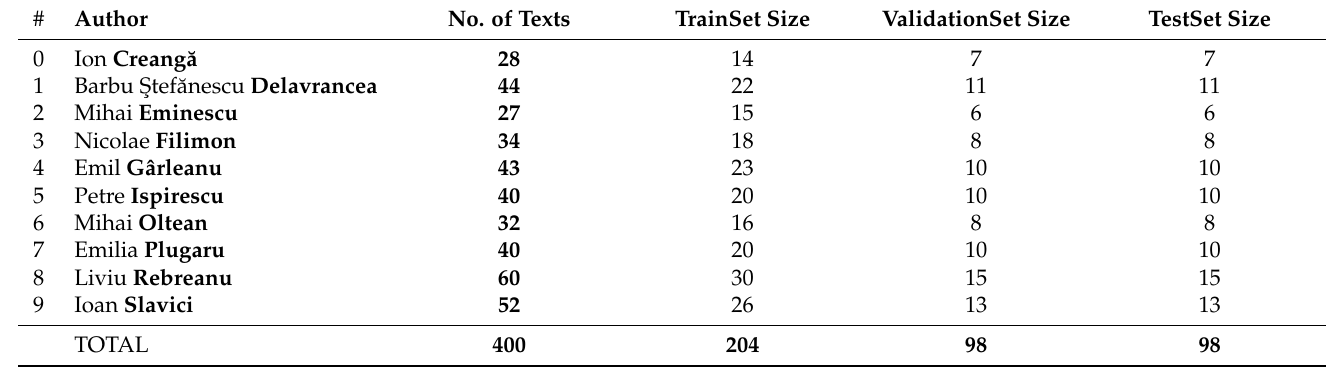
Table 8. List of authors (the author’s last name is in bold); the number of texts and their distribution on the training, validation, and test sets. The total number of texts per author, per set, and grand total are in